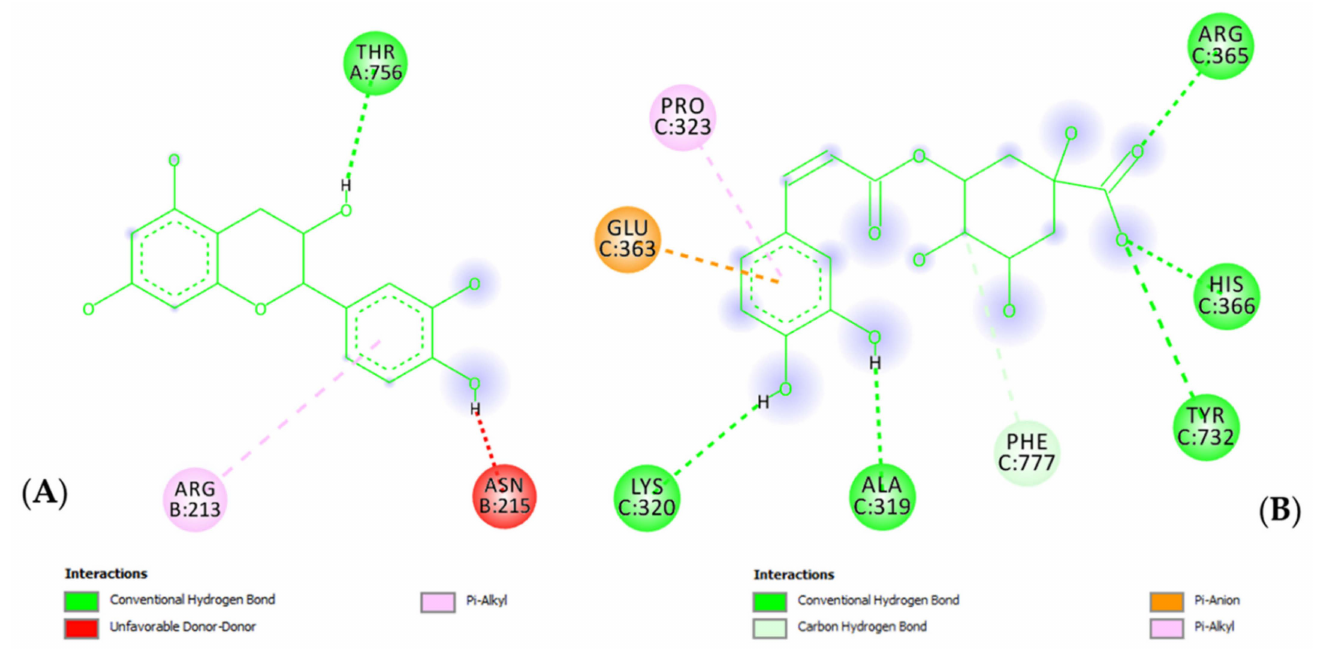
Figure 8. ( A ) Putative interactions between catechin and TRPV1 receptor (PDB ID: 7LR0). Free energy binding ( ∆ G) and putative affinity ( K i ) are − 6.8 kcal/mol and 10.5 µ M, respectively. ( B ) Putative interactions between chlorogenic acid and TRPV1 receptor (PDB ID: 7LR0). Free energy binding ( ∆ G) and putative affinity ( K i ) are − 6.7 kcal/mol and 12.5 µ M,